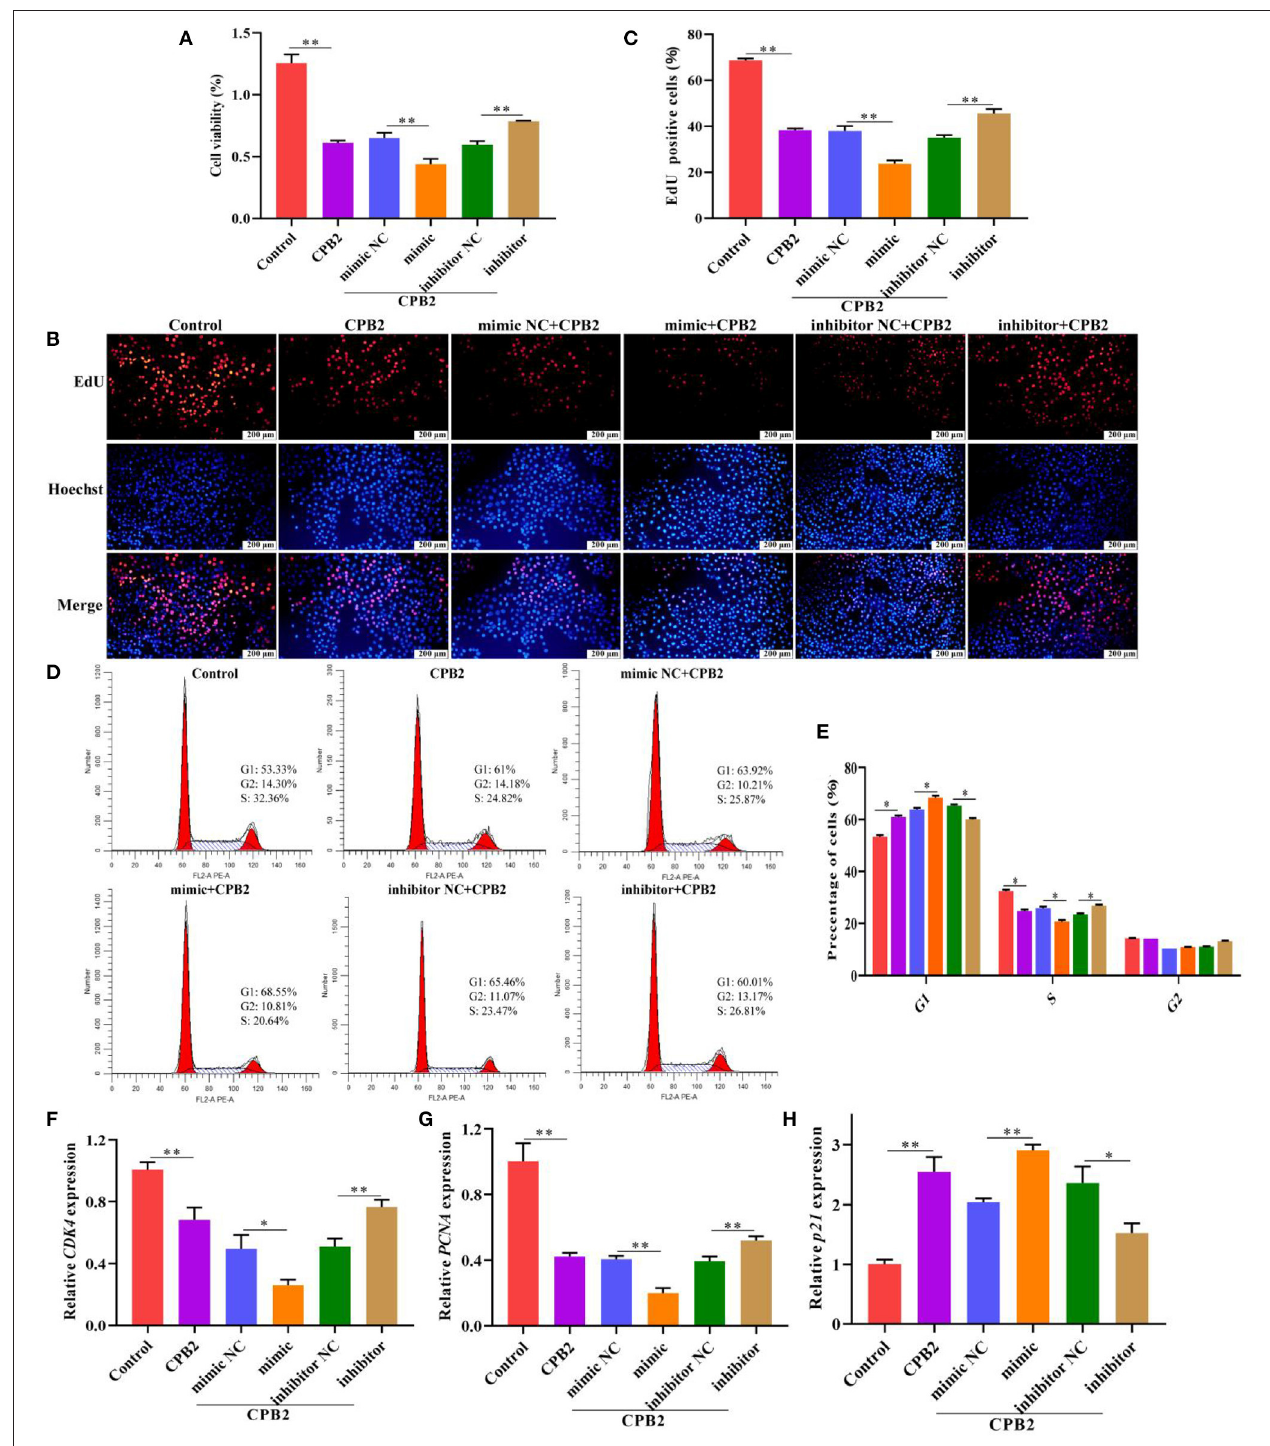
FIGURE 3 | miR-30d arrested cell proliferation and cycle progression in CPB2 toxin revulsive IPEC-J2 cells. (A–H) The IPEC-J2 cells were transfected with mimic NC, miR-30d mimic (50nM), inhibitor NC, and miR-30d inhibitor (150nM), and treated with CPB2 toxin for 36h. (A) CCK-8 was performed to analyze cell viability, and the results were recorded using a microplate reader at 450nm. (B) The EdU assay was performed. The IPEC-J2 cells in S-phase were stained red with EdU, whereas the nucleus was dyed blue with Hoechst. (C) Image J analysis of the proportion of proliferating cells. (D,E) Flow cytometry analysis of the IPEC-J2 cell cycle. (F–H) qPCR analysis of CDK4 , PCNA , and p21 expression. * p < 0.05, ** p < 0.01.